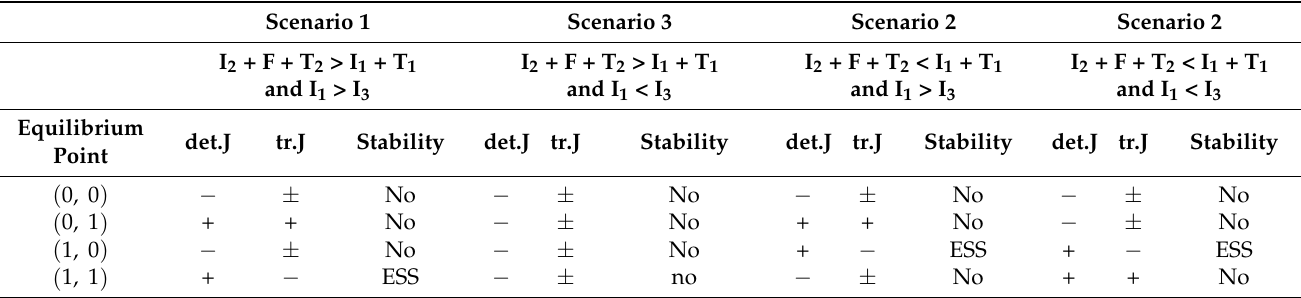
Table 4. Results of the local equilibrium stability of the game system between farmers and local